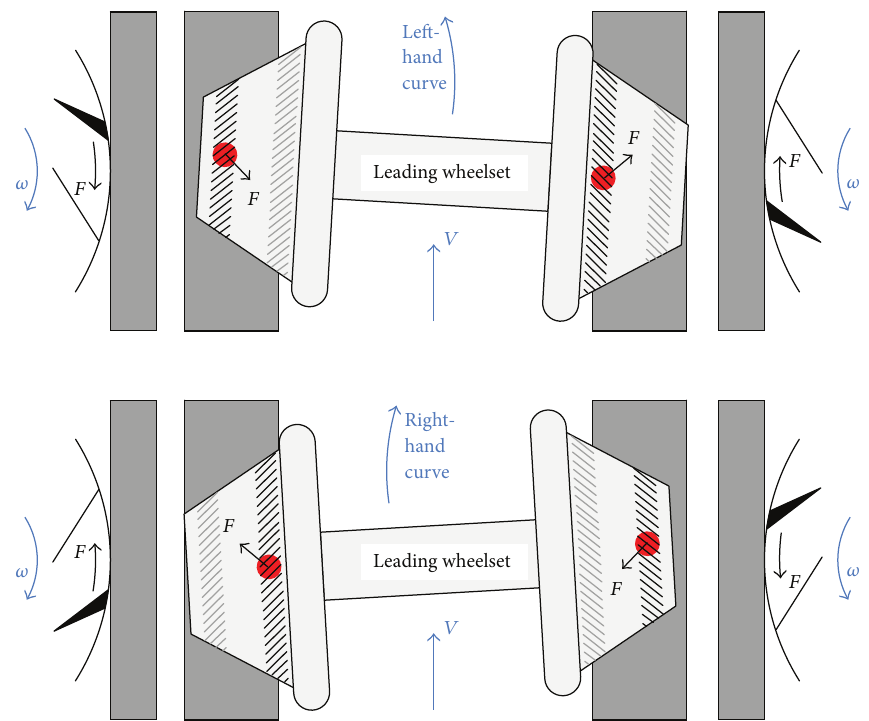
Figure 5: Orientation of leading wheelset on left and right hand curves, showing position of wheel/rail contact, direction of tangential force, and formation of two bands of cracks. The cracks near the flange of the wheel tend to be forced closed before contacting the rail and do not tend to propagate deep into the wheel. In contrast, the cracks near the field side of the wheel are forced open before they contact the rail; fluid entrapment and pressurisation in the contact can propagate these cracks into the underlying material.